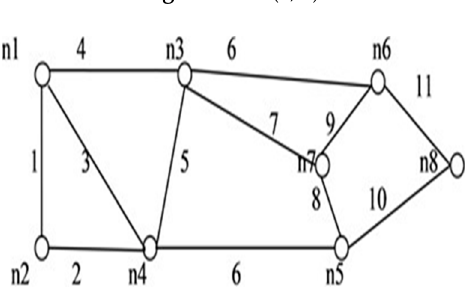
Figure 10. G (6, 9).